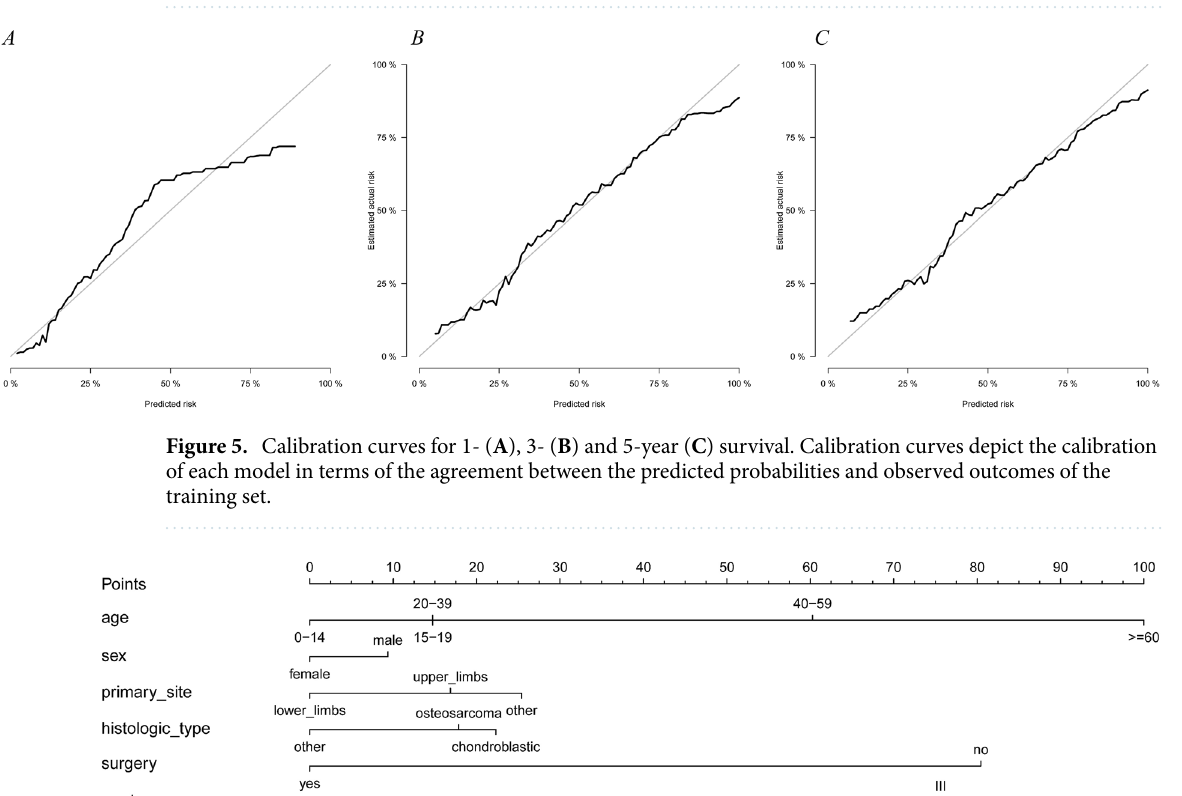
Figure 4. ROC curves. ROC curve analyses were generated to test the performance evaluating of the established predictive model, by the areas under the ROC curves (AUC). ( A – C ) ROC of 1-, 3- and 5- year, respectively.